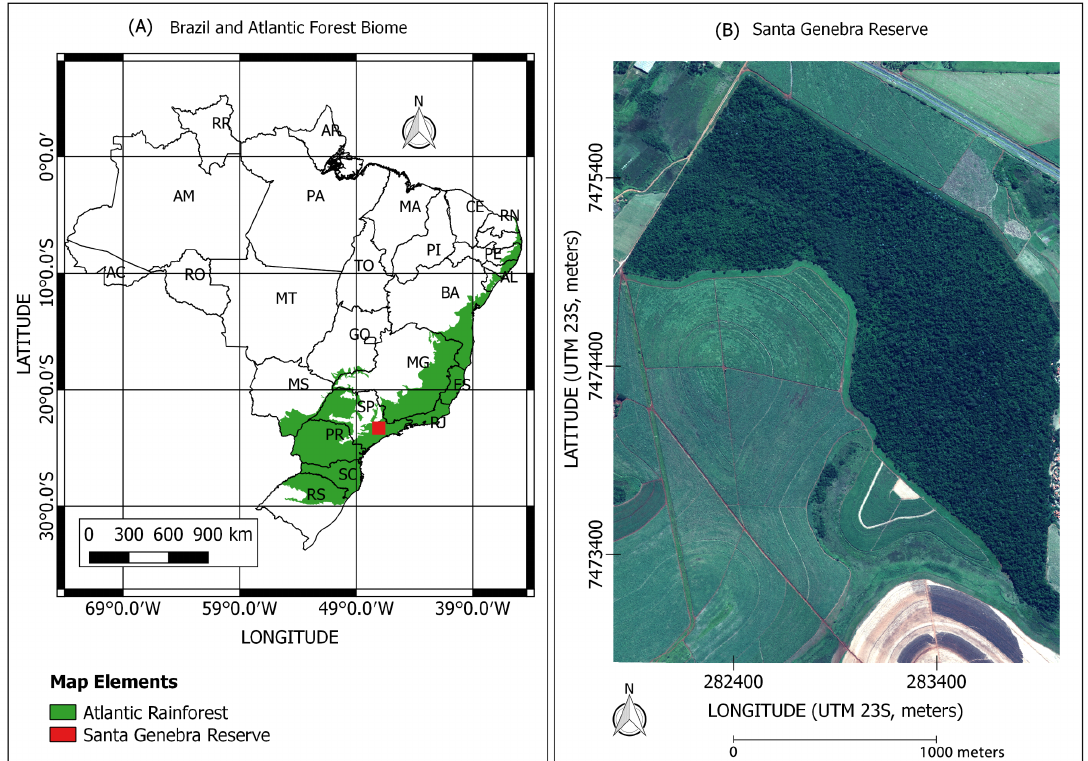
Figure 1. ( A ) The Brazilian territory. In green, the Atlantic Rainforest biome extension, and the red square marks the location of Santa Genebra Reserve; ( B ) True color composition of the WorldView-2 image acquired over the Santa Genebra Forest